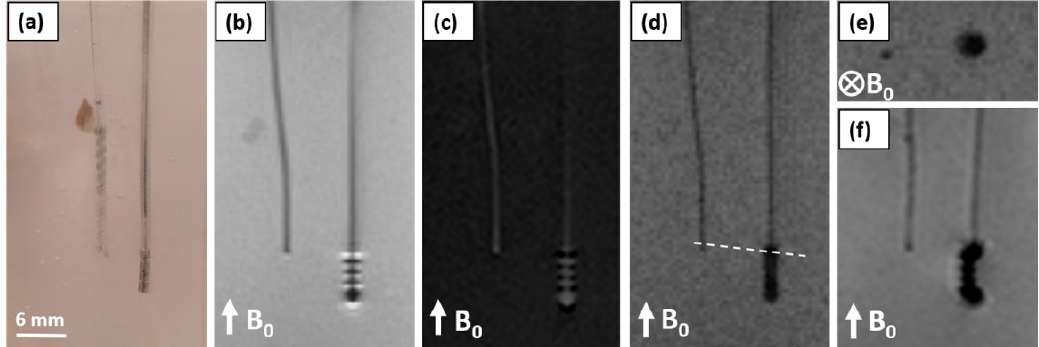
Figure 7. Comparison of the hybrid probe with a conventional DBS probe with respect to implant localization and imaging artefacts due to the electrode material in common MRI sequences using a 1.5 T scanner; ( a ) Photograph of the hybrid probe (left) and the conventional 3389 Medtronic ® DBS probe (right) in a 1% agarose phantom; ( b ) Coronal view using a Turbo Spin Echo sequence; ( c ) Coronal view using an Inversion Recovery sequence; ( d ) Coronal view using a Gradient Echo sequence; ( e ) Transversal view along dashed line in ( d ) using a Gradient Echo sequence; ( f ) Coronal view using an Echo Planar Imaging sequence. Both devices have a similar diameter range (hybrid probe 1.19 mm; conventional DBS 1.27 mm) the displayed diameter at the tip of the conventional DBS probe, however, appears larger due to susceptibility artefacts.